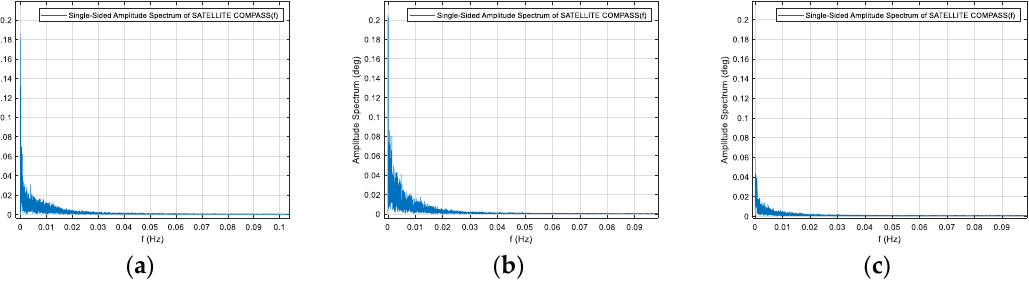
Figure 10. Heading registration spectrum for the three compasses: ( a ) Advanced Navigation, ( b ) Furuno, ( c ) Novatel. Stationary experiment, 27,28 April 2020.